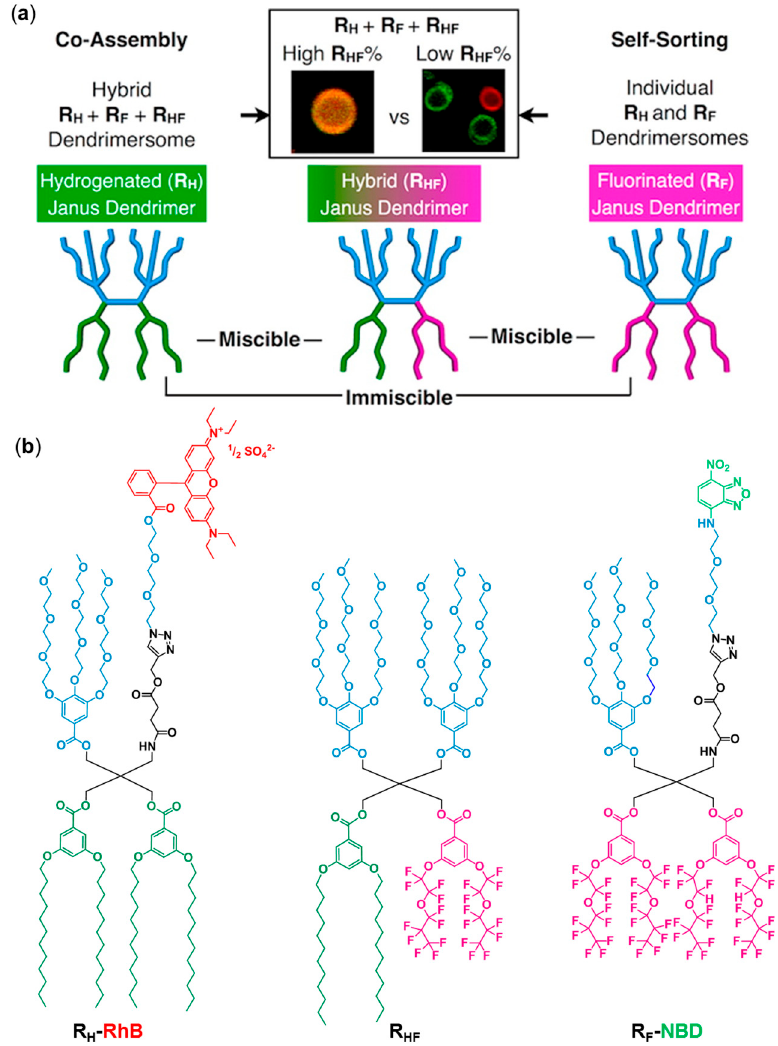
Figure 18. ( a ) Scheme illustrating the coassembly of hybrid R HF Janus dendrimer with both R F and R H . Three-component hybrid DSs containing R H , R F , and R HF were formed when the proportion of R HF was higher than 40%. With low concentration of R HF and in its absence, R H and R F self-sorted into individual R H or R F DSs. ( b ) Structure of the two dye-labeled fluorescent JDs with R F (R F -NBD) or R H (R H -RhB) chains and non-fluorescent R HF . Copyright American Chemical Society, ( a ) reprinted from Journal of the American Chemical Society 2016 [67].